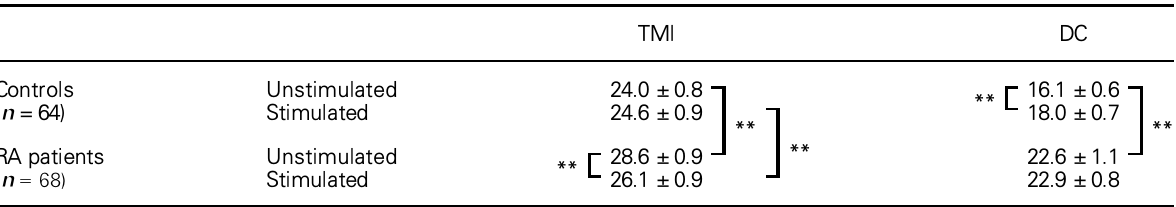
Table 1. Total migration index (TMI) and distribution characteristic (DC) of blood PMNs in 68 migration tests as described in Patients and Methods of 15 RA patients compared with 64 healthy controls. The data represent mean values of triplicate measurements ± SEM in unstimulated (spontaneous migration) or fMLP-stimulated samples of RA patients and healthy controls